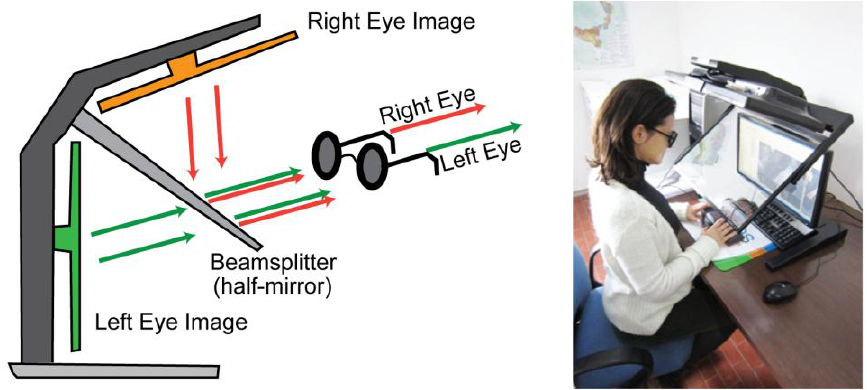
Figure 3. Schematic of the StereoMirror™ technology (http://www.planar.com/media/